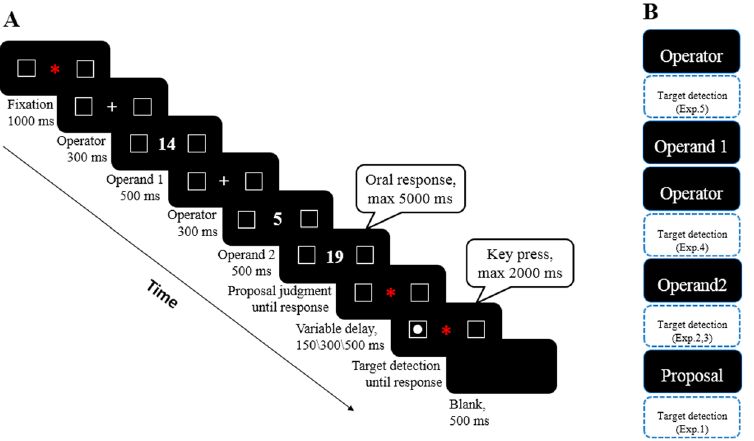
Figure 1. ( A ) Task sequence and timing of a sample trial. The operator, first operand, second operand and the proposed result (proposal) were presented sequentially at the center of the screen. The target (a white solid circle) was randomly presented on either the left or right side on 80% of all trials. Targets disappear as soon as participants respond, or remain on the screen with a maximum duration of 2000 ms. Similarly, the proposal would not disappear until participants give an oral response through a headset microphone, but with a maximum duration of 5000 ms. ( B ) General trial structure across the five experiments. Blue rectangles with dotted line indicate the location of the target detection task, which is different from Experiment 1 to 5. Stimuli for the arithmetic task (same in each experiment) are depicted by black filled